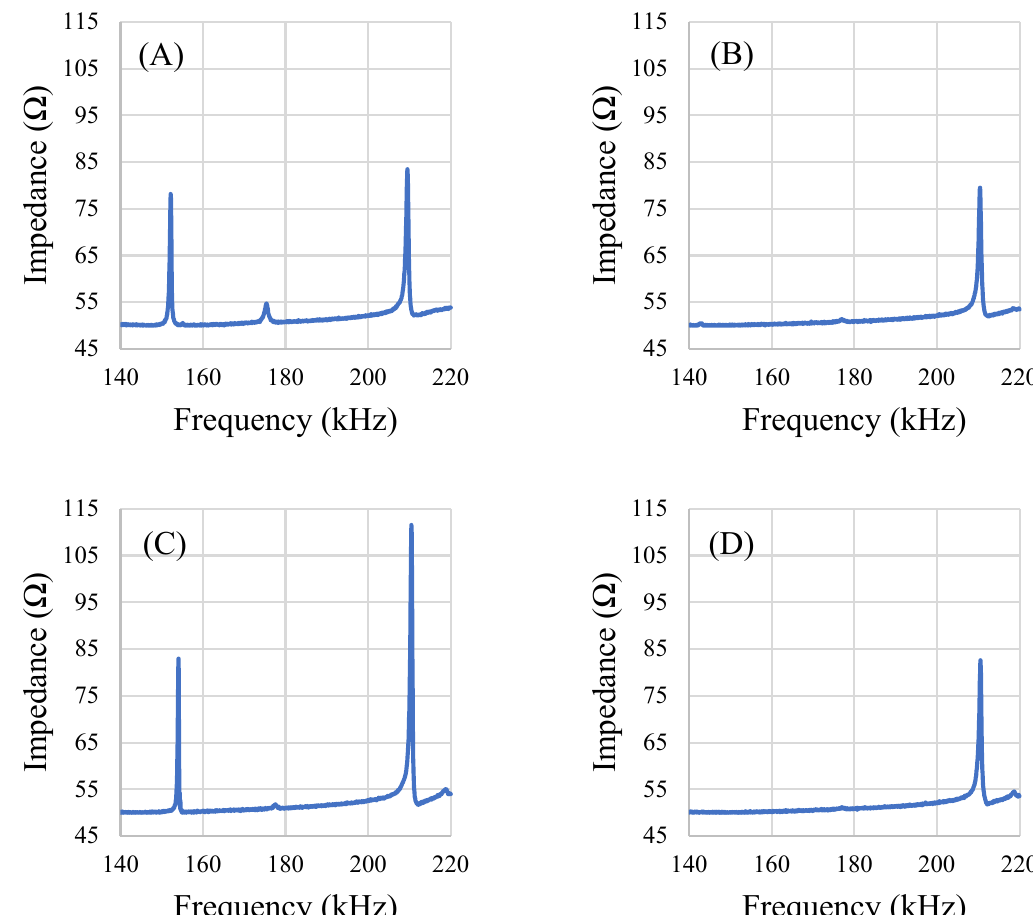
Figure 9. Plots of a single square sensor’s resonances at 0° ( A ), 45° ( B ), 90° ( C ), and 135° ( D ) rotations from the normal orientation.